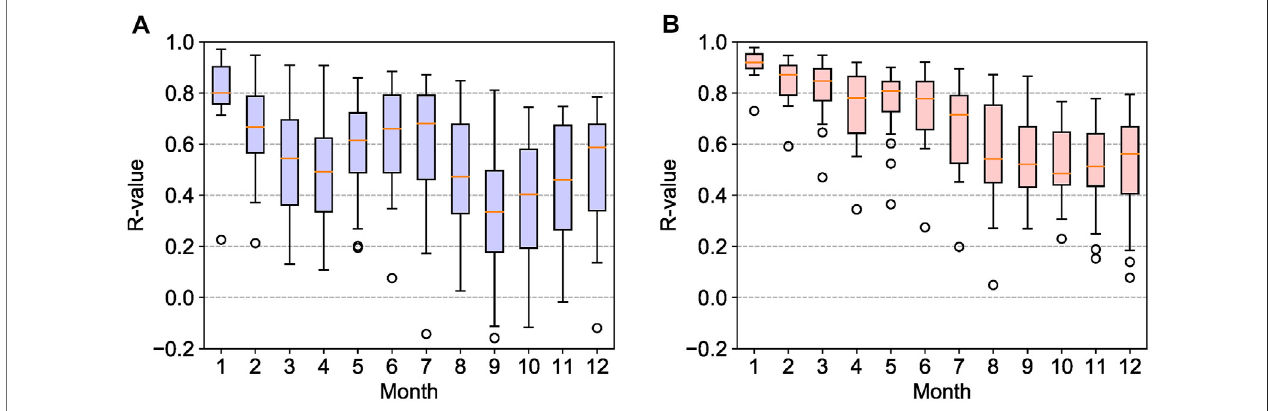
FIGURE 10| Comparisonof R valuesbetweenLSTMmodelandwavelet-LSTMmodelduringthetestingperiodfor1 – 12 monthsforecast: (A) LSTM (B)